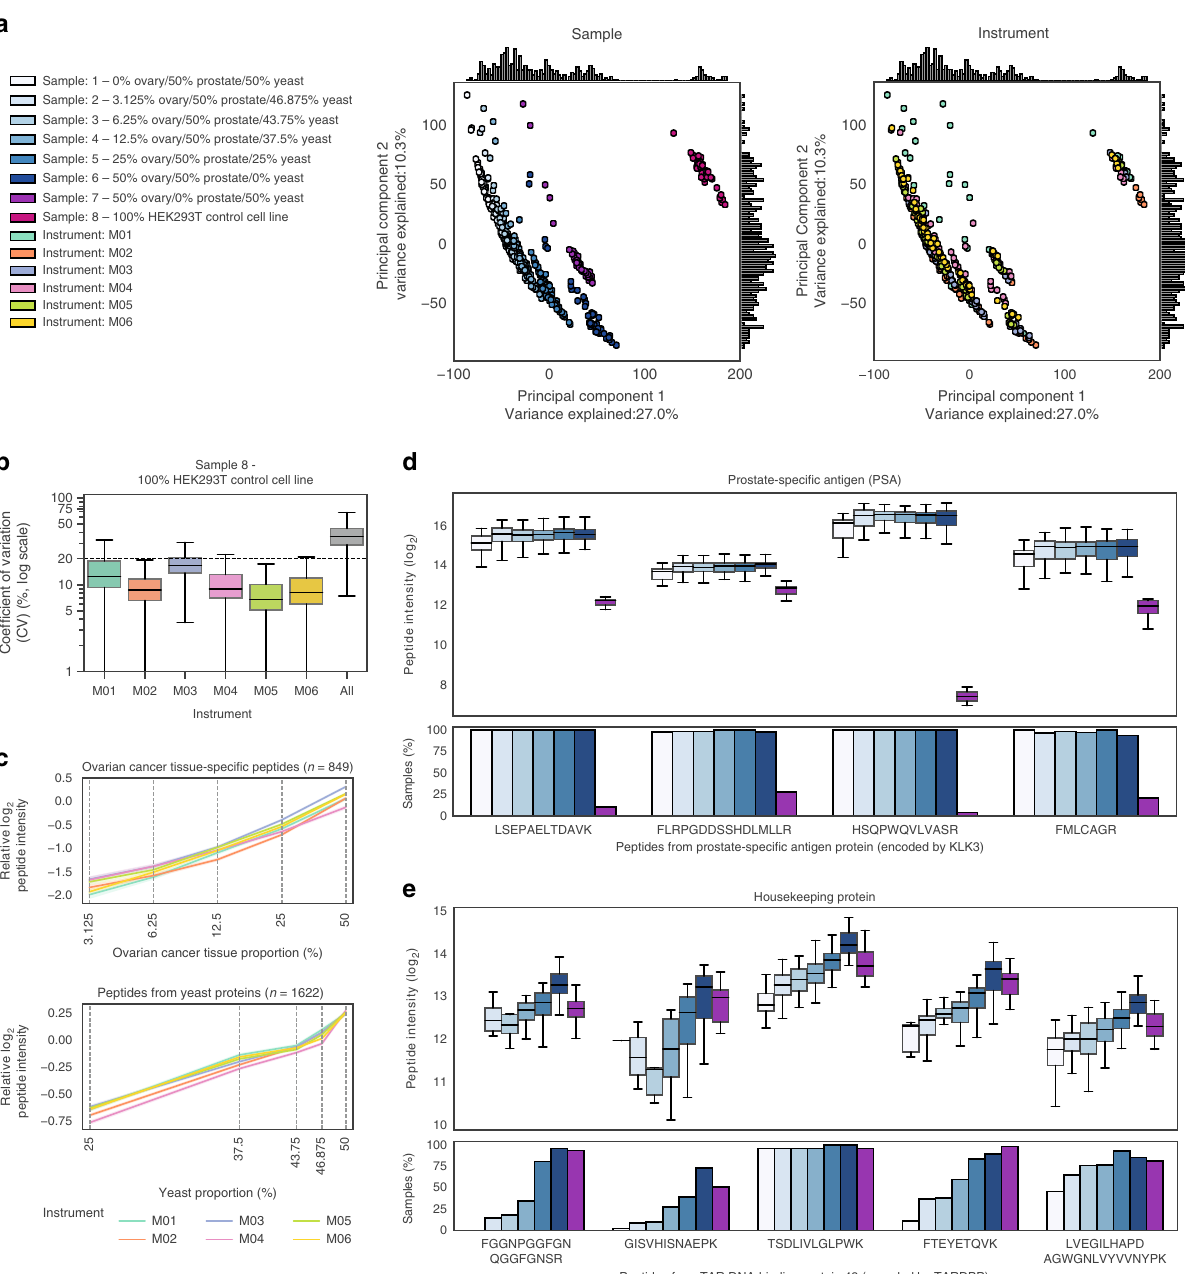
Fig. 2 Baseline DIA-MS data reproducibility. Data shown in all plots were acquired during the experimental week after instrument cleaning (days 101, 103, 105 and 107) and were not normalised. a Principal component analysis of log 2 -transformed experimental data, with data points coloured by sample (left) and instrument (right). Missing values were fi lled with zeros. b Coef fi cient of variation (CV) per instrument in the HEK293T control cell line (Sample 8). CV was calculated using frequently observed peptides ( n = 2950 peptides). A black dashed line marks a CV of 20% for reference. c Relative log 2 - transformed intensities per sample of ovarian cancer-tissue speci fi c peptides (upper) and peptides from yeast proteins (lower), coloured by instrument. The mean peptide intensity from each sample was adjusted so that relative intensities are comparable, by dividing each value by the overall mean peptide intensity measured on a given instrument during the period. Ovarian cancer tissue and yeast proportions are plotted on the log 2 -scale. d , e Intensities of all peptides identi fi ed from d the prostate-speci fi c antigen (PSA) protein encoded by KLK3 and e the housekeeping protein encoded by TARDBP . Boxplots show peptide intensity, with bar plots indicating the proportion of replicate samples in which each peptide was observed. Plots are coloured according to sample, using colour-codes as shown in a . For replicate numbers n , refer to Supplementary Data 2. In b , d and e , the box indicates quartiles and the whiskers indicate the rest of the distribution, with outliers not shown. Source data are provided as a Source data fi tissues. To assess RUV-III-C in this respect and to measure the Pearson correlation across each peptide increased from 0.25 effect across a larger number of peptides, we examined the before normalisation to 0.62 after normalisation, consistent with relationship between the intensity of all frequently observed an improvement in speci fi c signal detection (Fig. 3e). Median human peptides with ovarian cancer tissue content. The median normalisation and median normalisation plus ComBat 29 for